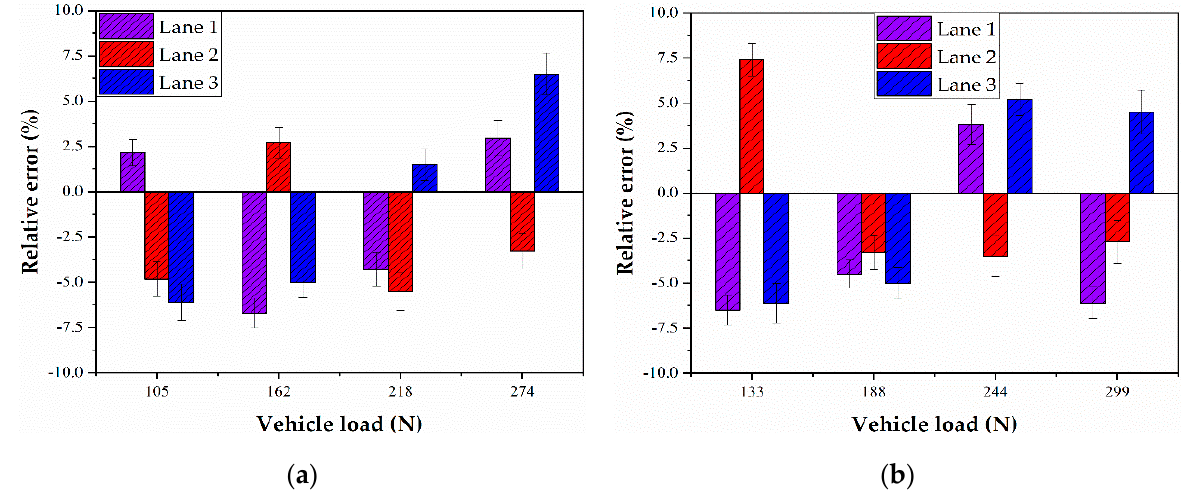
Figure 17. The relative error of vehicle weight identification: ( a ) Two-axle vehicle, ( b ) three-axle vehicle.